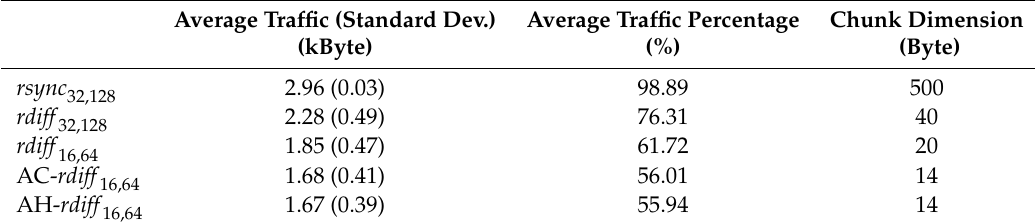
Table 2. Average data traffic generated by different synchronization algorithms. Average Traffic (Standard